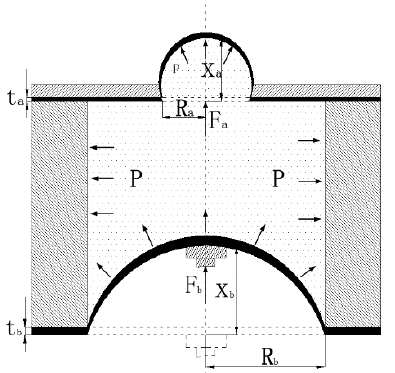
Figure 3. Simplified model of hydraulic amplifier unit.